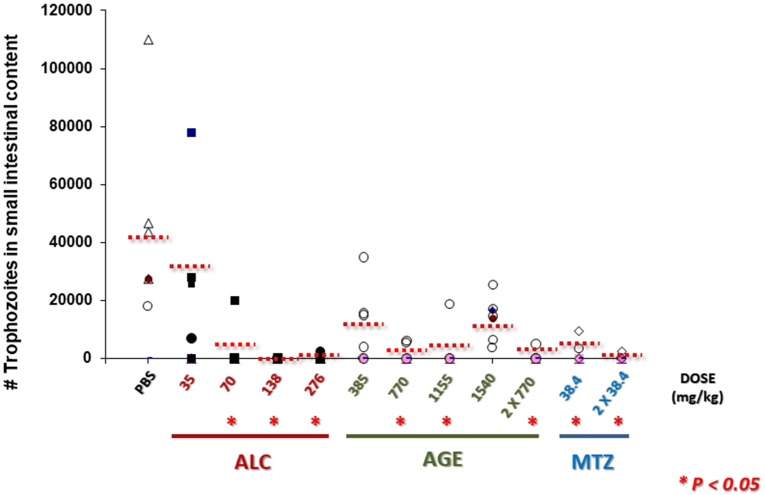
AGE and allicin diminish and eliminate G. duodenalis trophozoites in small intestines of infected gerbils. Male M. unguiculatus were intragastrically inoculated with 1 × 106 trophozoites per os. At day 10 p.i. gerbils were treated with AGE (single or doubled doses), ALC at single doses or metronidazole (MTZ) at single or double dose as indicated. At day 13 p.i. trophozoites in intestinal contents (10 cm-long sections) were counted. Punctuated lines indicate the mean values of intestinal trophozoites for each group. Asterisks indicate counts significantly lower than control group (PBS) at P < 0.05.